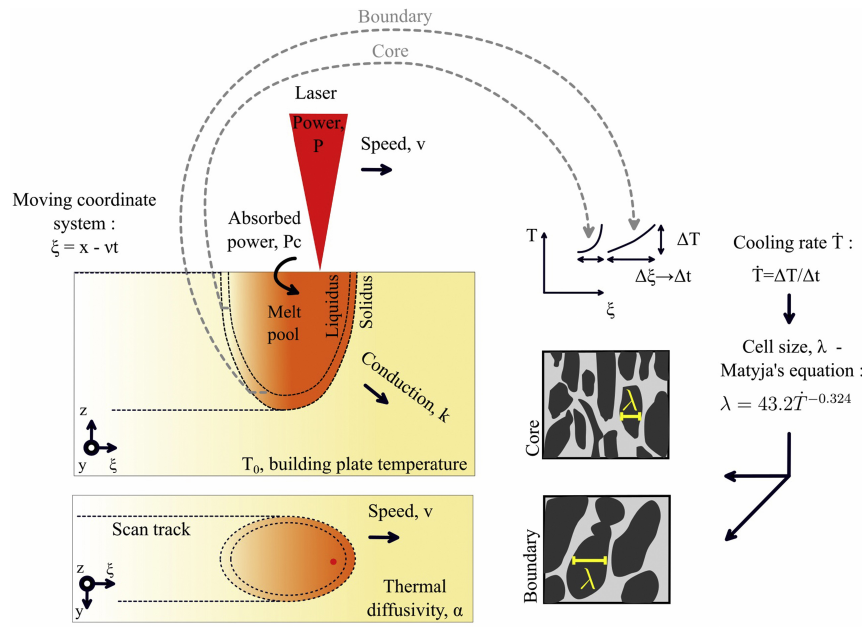
Figure 13. Method to compute the cell size with the melt pool depth using Rosenthal’s